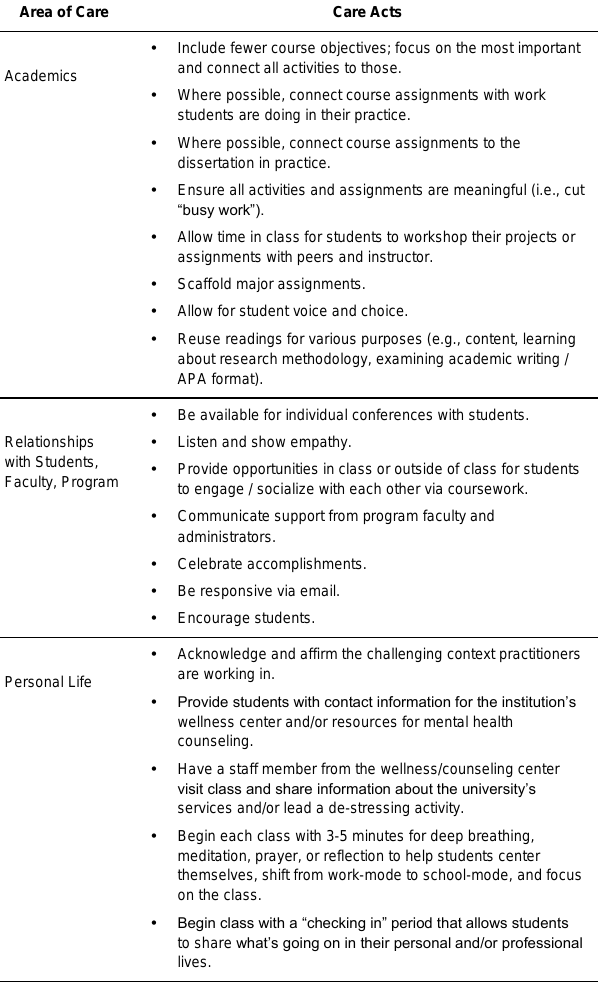
Table 1. Examples of Care Acts to Support EdD Scholar- Practitioners Area of